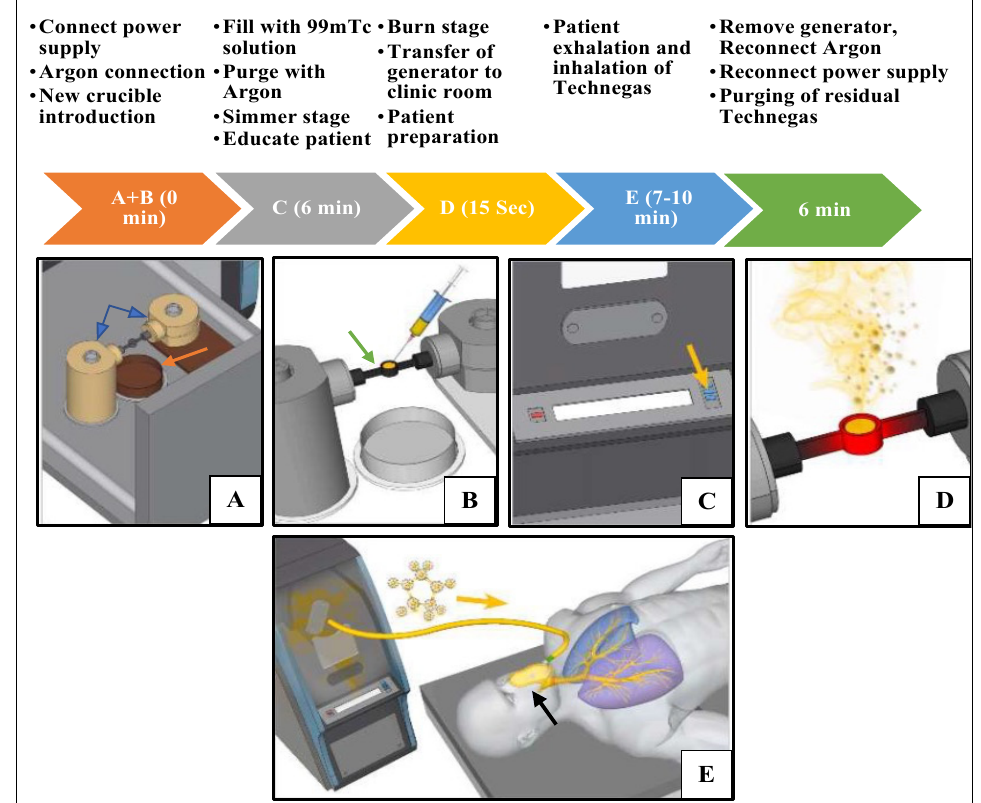
Figure 3. Principles for the operation of Technegas generator for lung imaging. ( A ) Contacts (blue arrows) and collection tray (orange arrow), ( B ) Pulmotec ® graphite crucible (green arrow), ( C ) start simmering button (yellow arrow), ( D ) burn stage, ( E ) inhalation stage using patient administration set (black arrow). (Inset courtesy of